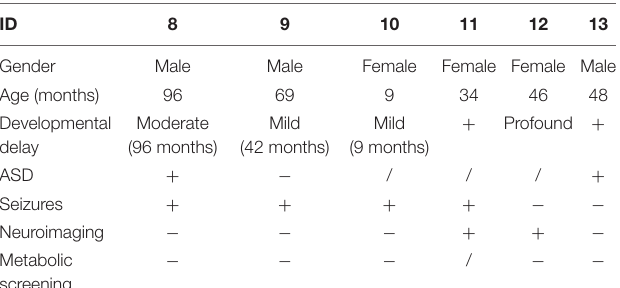
TABLE 2 | Clinical information of six patients reported